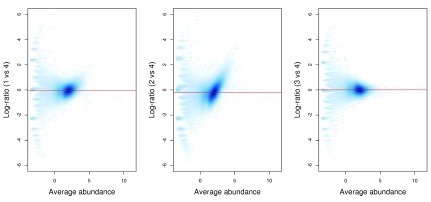
Mean-difference plots for the bin counts, comparing library 4 to all other libraries.The red line represents the log-ratio of the normalization factors between libraries.